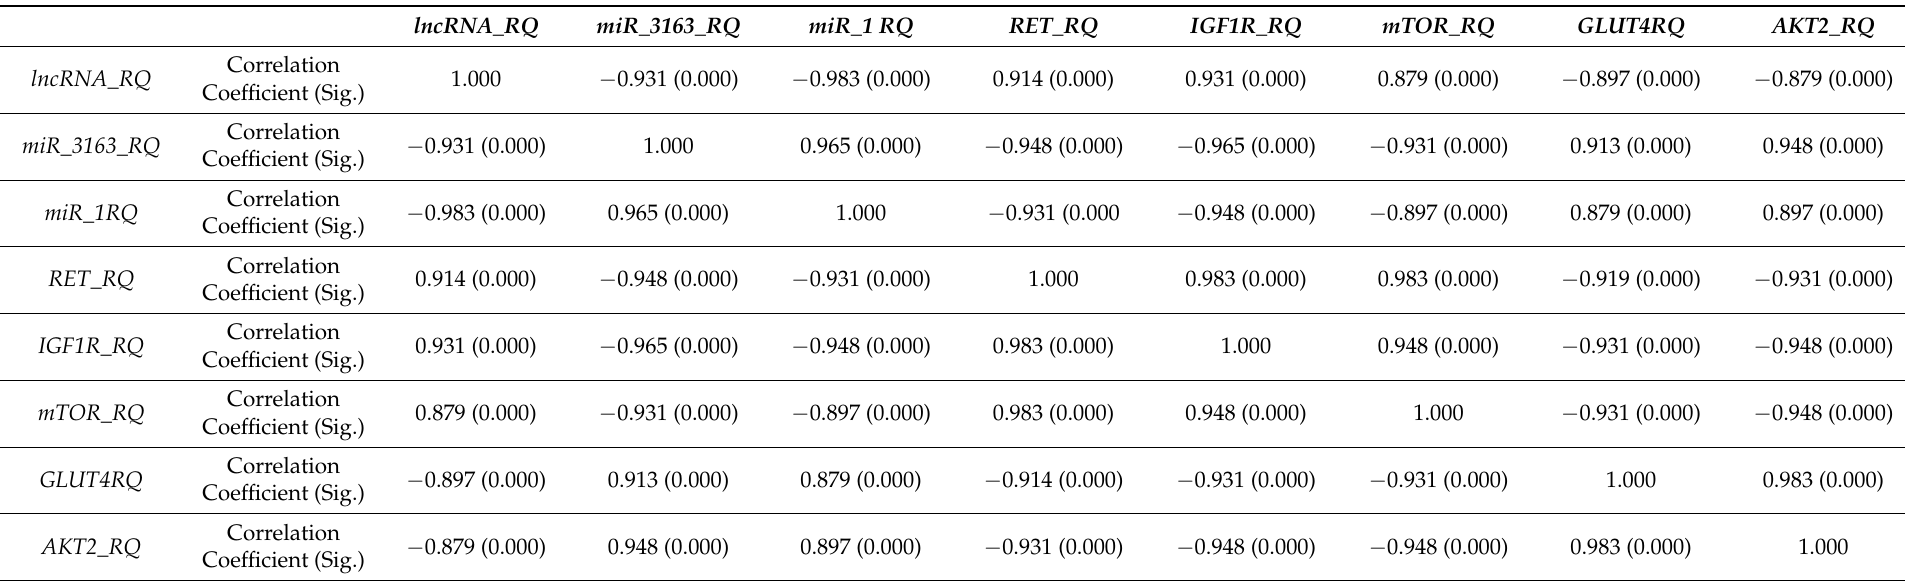
Table 5. Correlation between the investigated candidate genes expression in the three investigated lymphocyte cell lines ( n =